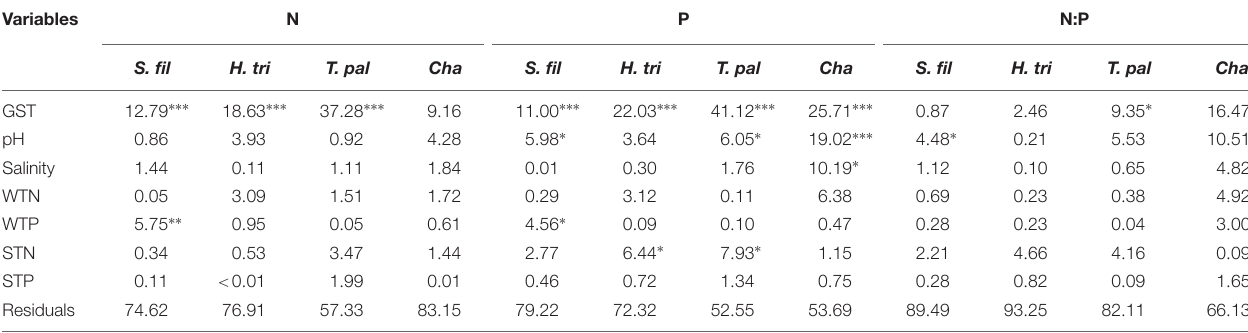
The %SS represents the explanatory degree of each explanatory accounted for. The explanatory variables include growing season mean temperature (GST), water pH value, salinity, water total nitrogen content (WTN), water total phosphorus content (WTP), soil total nitrogen concentration (STN), and soil total phosphorus concentration (STP). S. fil, Stuckenia filiformis; H. tri, Halerpestes tricuspis; T. pal, Triglochin palustris; Cha, Charophytes. ∗ p < 0.05, ∗∗ p < 0.01, ∗∗∗ p <